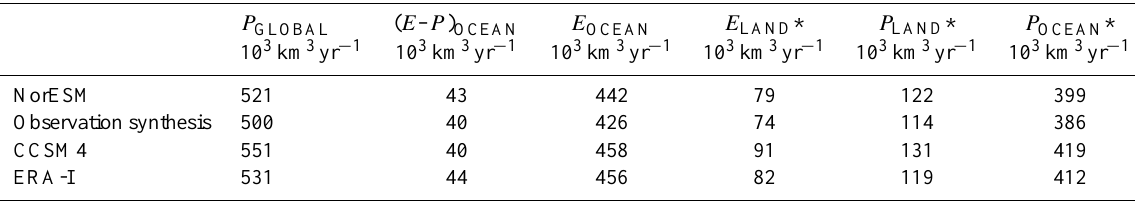
Table 2. Calculated key elements of the gross cycling of fresh water in the earth system valid for the early years after 2000. Values from the NorESM Historical1 experiment (years 2000–2005) are compared to values for CCSM4 (Gent et al., 2011; years 1990–2000), ECMWF ERA- Interim reanalysis (years 2002–2008), and observationally based estimates (years 2002–2008). The three latter sets of numbers are provided by Trenberth et al. (2011). Quantities marked with an asterisk (*) are, for NorESM only, estimated using E = P globally integrated. See also Table 5 in Iversen et al.